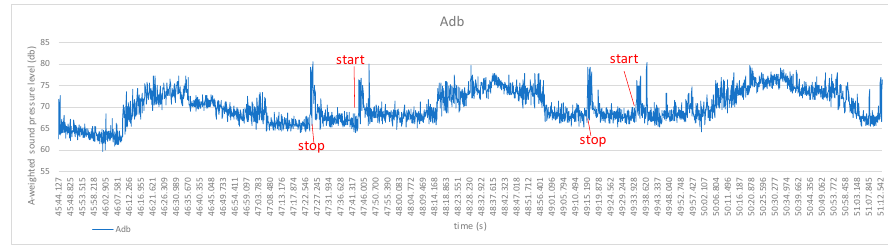
Figure 8. Decibels in the test process.